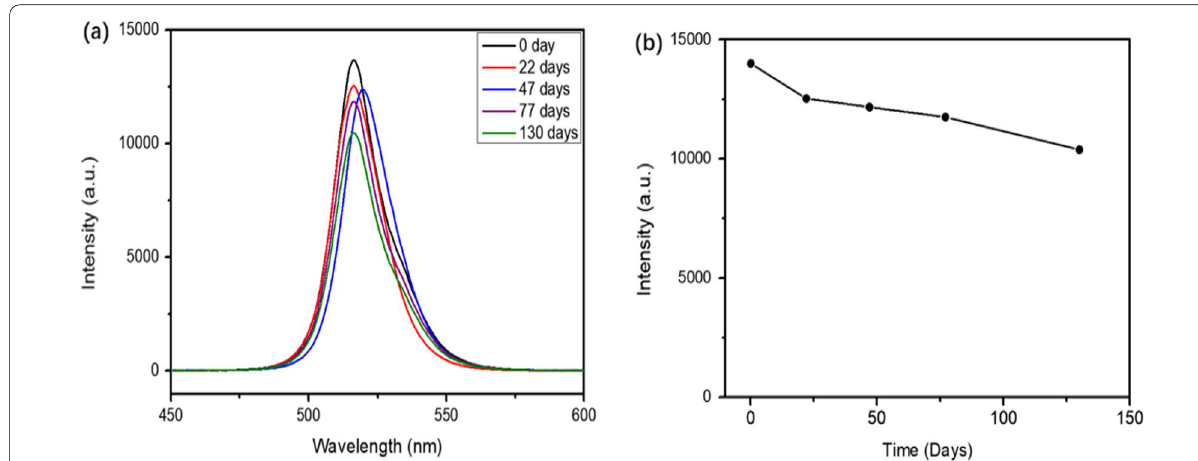
Fig. 10 a Peak position of the PL spectrum with different storage times in ambient air (λex